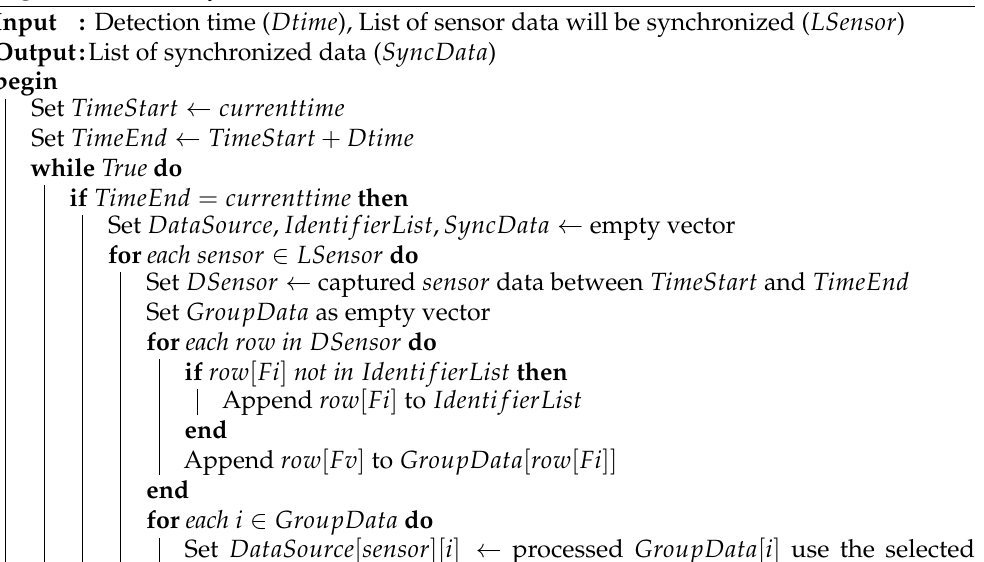
Algorithm 2 Data